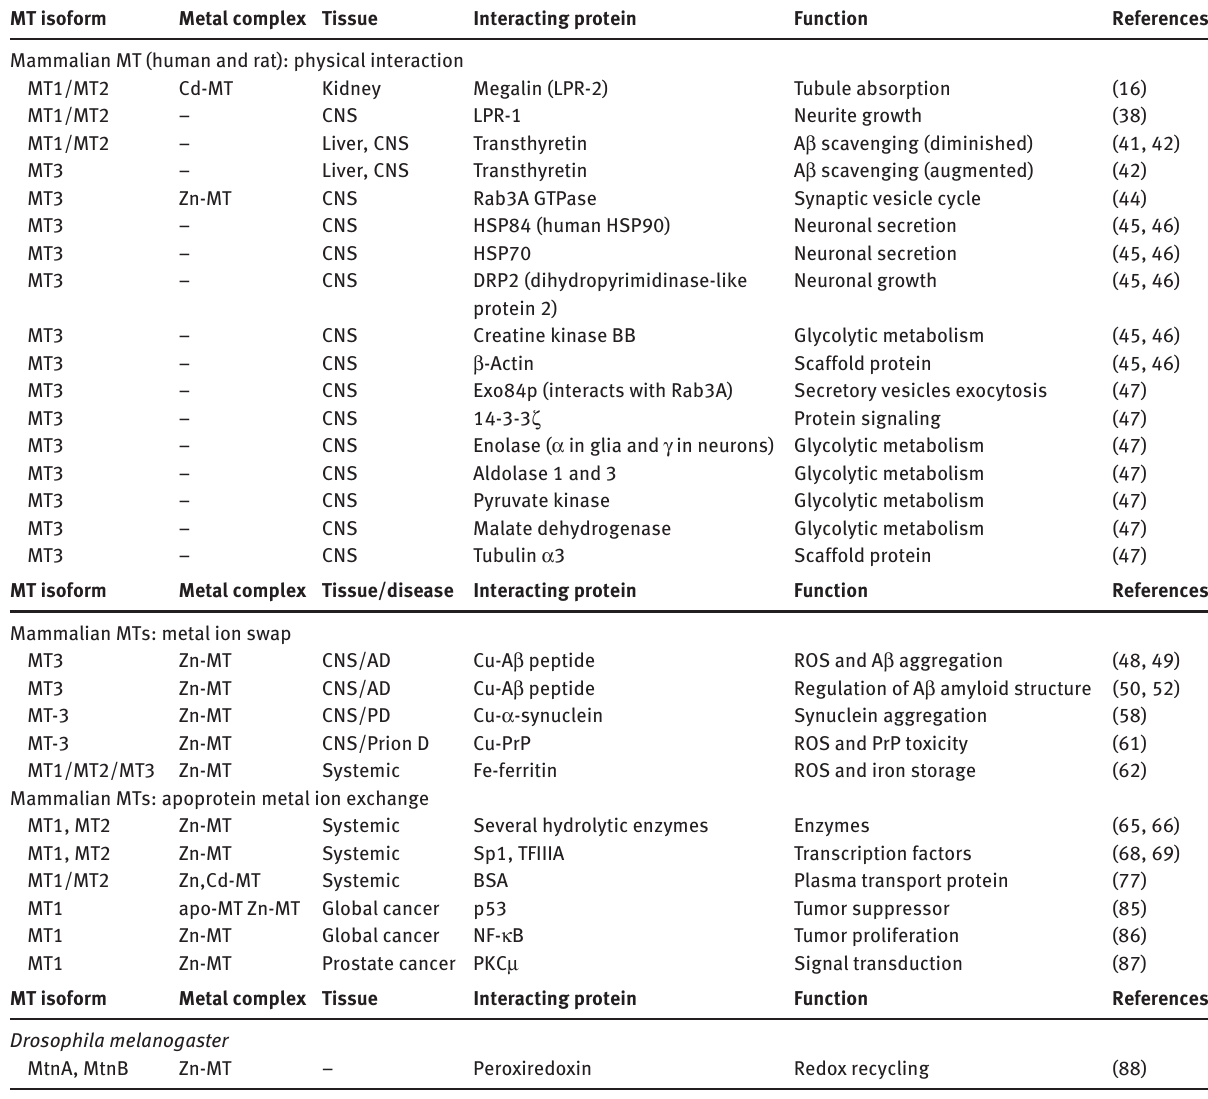
Table 2 Summary of reported MT-protein physical interactions and metal exchange reactions. MT isoform Metal complex Tissue Interacting protein